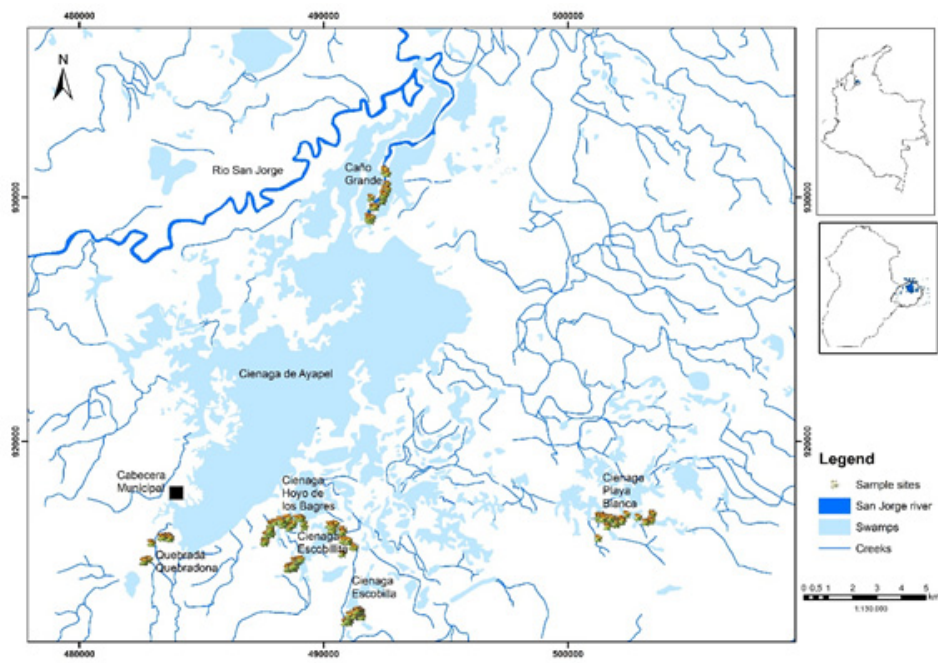
Figure 1. Sampling sites in Ayapel swamp complex: Caño Grande (CG), Quebrada (QQ) Quebradona, Hoyo los Bagres Swamp (HBS), Escobillita Swamp (EtS), Escobillas Swamp (EIS) and Playa Blanca Swamp